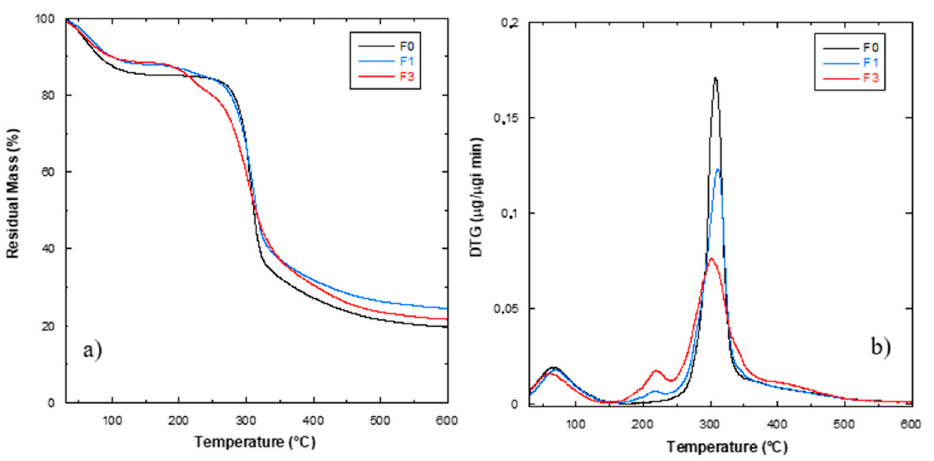
Figure 1. Mass loss (TG) ( a ) and derivative mass loss (DTG) ( b ) curves of F0, F1 and F3 samples.